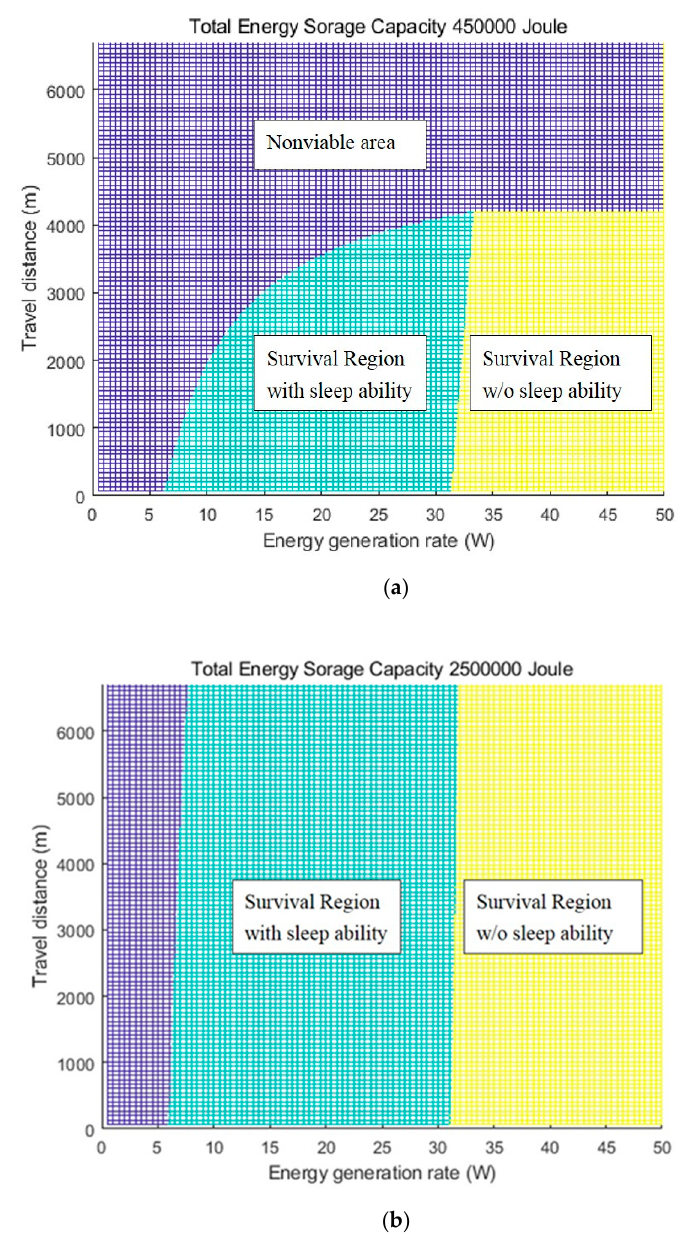
Figure 4. Robot survival region. ( a ) Total energy storage capacity 450 kJ; ( b ) Total energy storage capacity 2500 kJ.